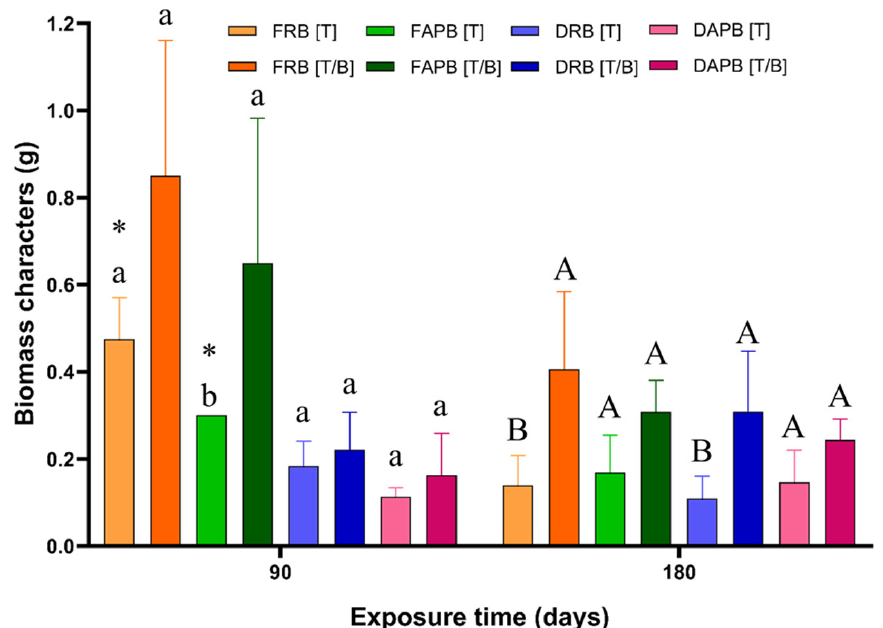
Figure 1. Size and biomass characters for P. laevigata growing on tailing (T) and tailing/biochar (T/B) in in situ conditions during 90 and 180 days. APL = aerial part length, RL = root length, BD = basal diameter, FRB = fresh root biomass, FAPB = fresh aerial part biomass, DRB = dry root biomass, DAPB = dry aerial part biomass. Different lowercase letters denote significant differences among treatments after 90 days of the exposure (Tukey p < 0.05). Different uppercase letters denote significant differences among treatments after 180 days of the exposure (Tukey p < 0.05). * = statistical differences between exposure times for each character.